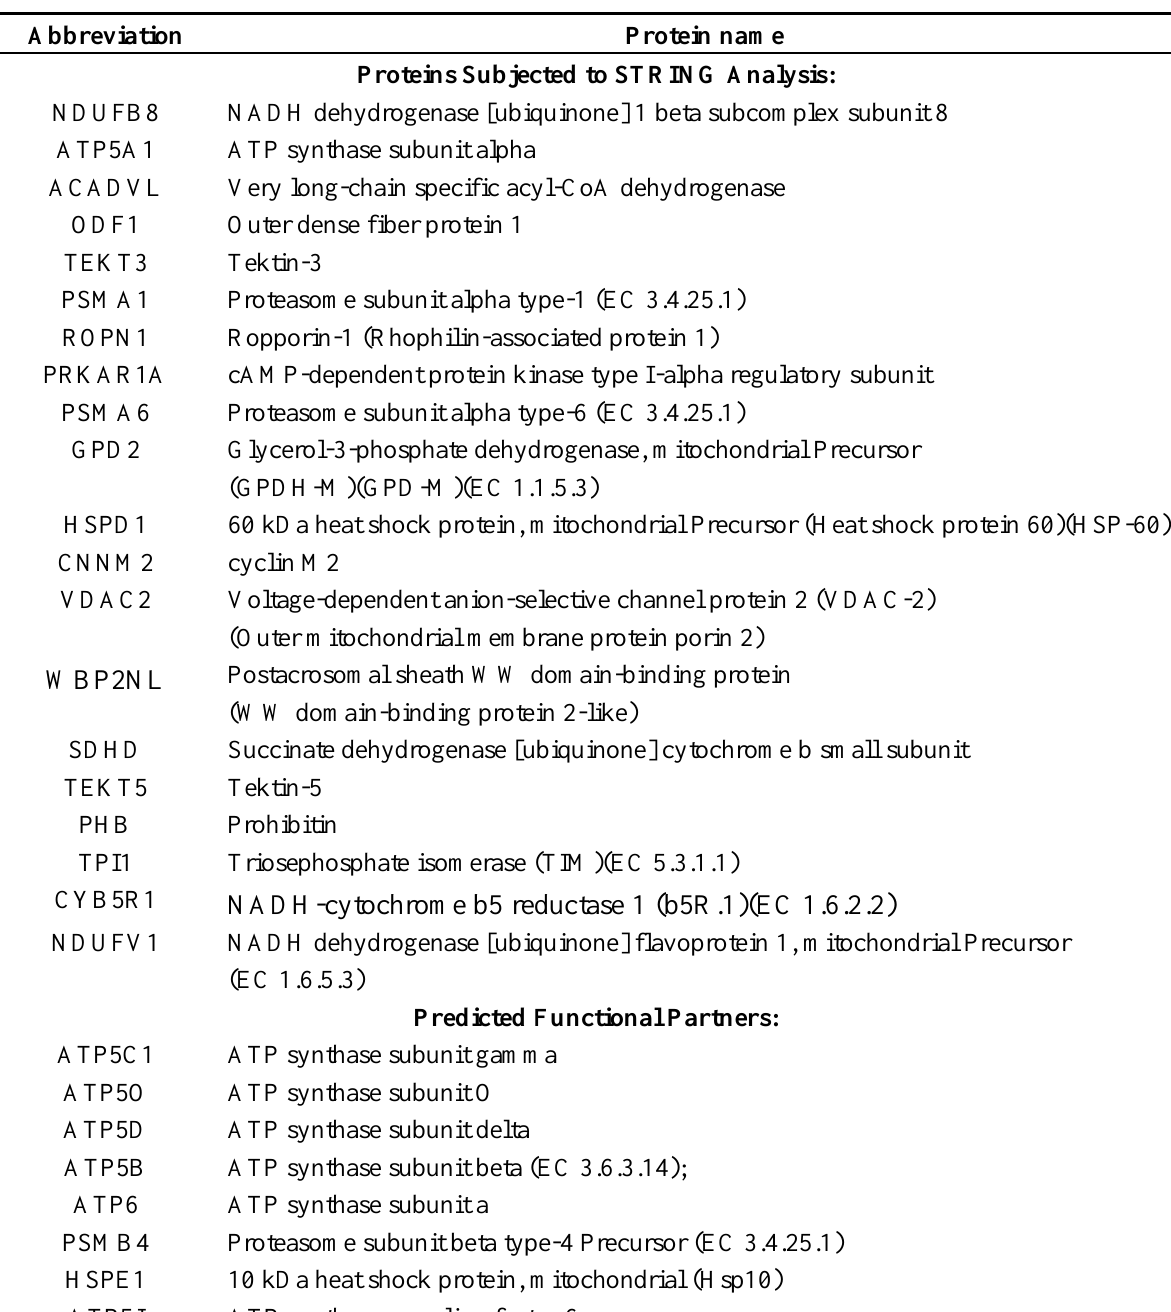
Table 2. Protein names and abbreviations used for STRING network